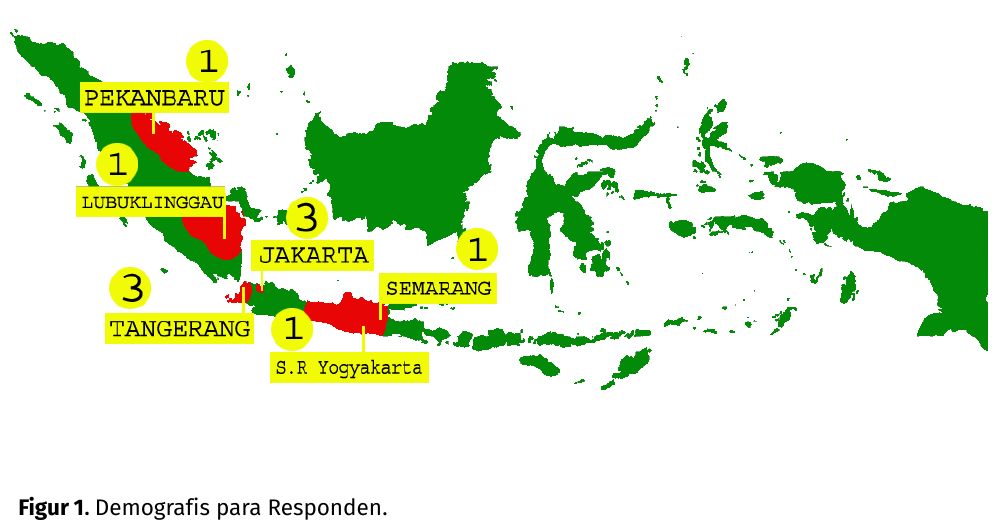
Figur 1 . Demografis para